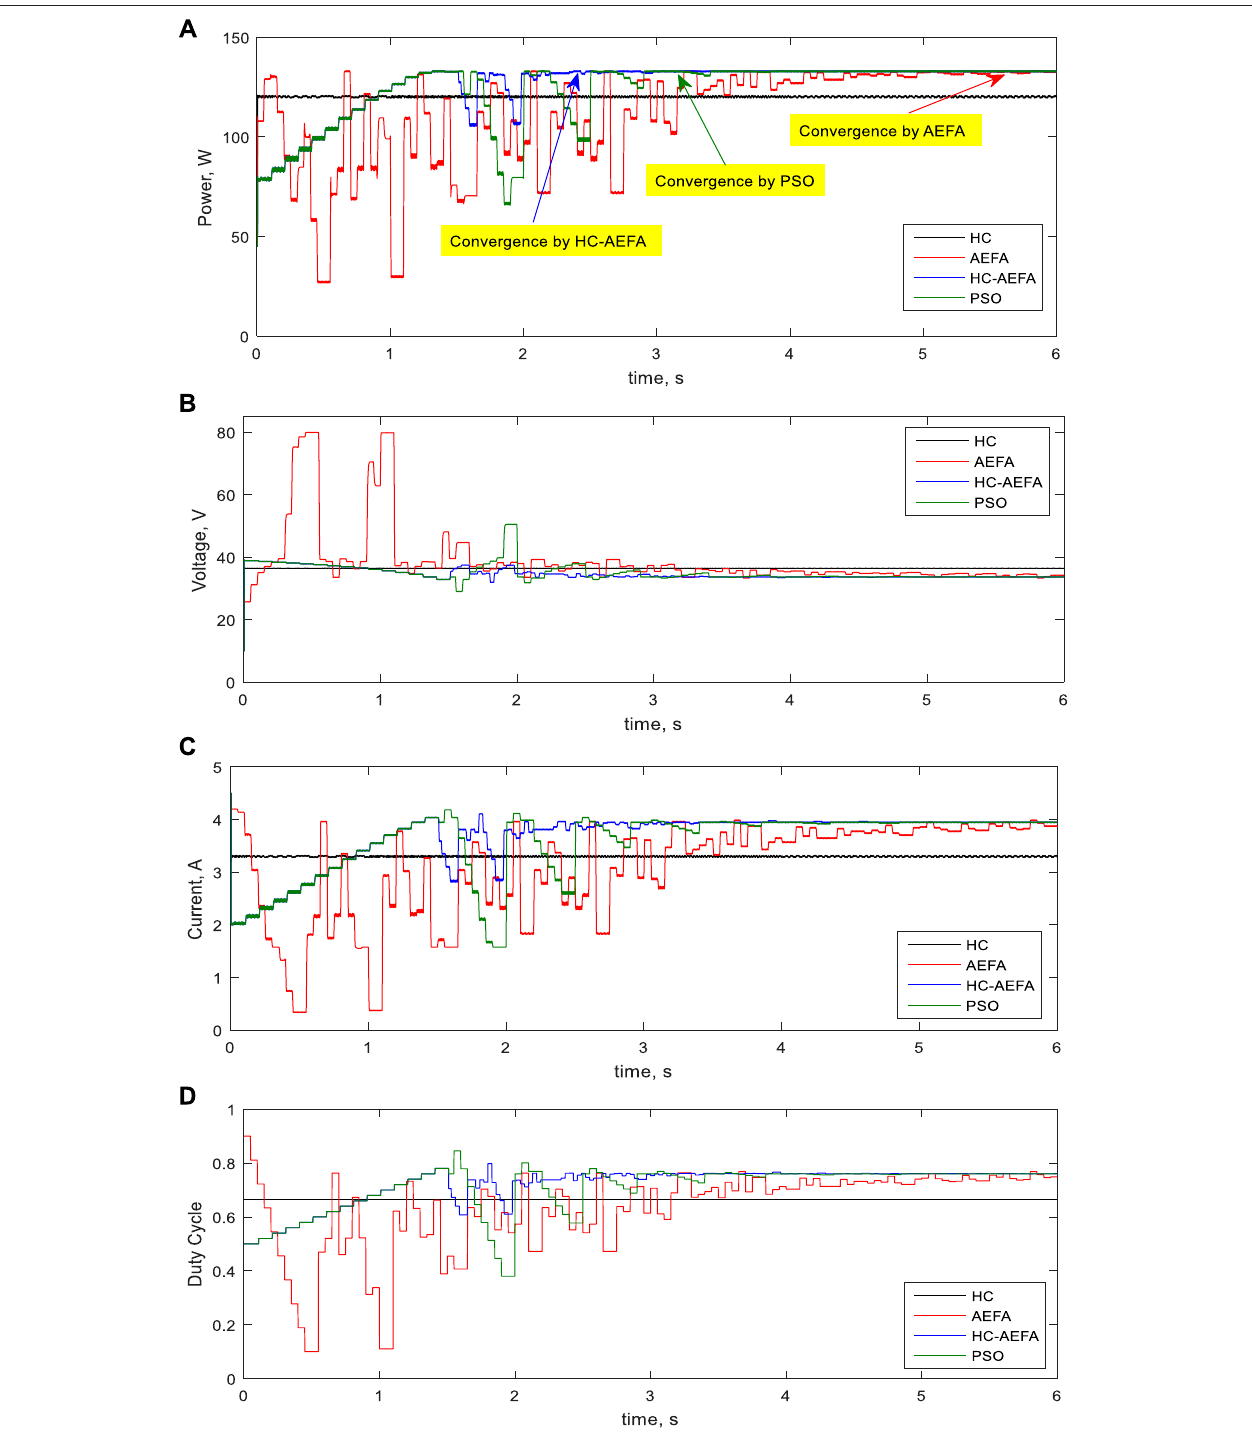
FIGURE 10 | Simulation waveforms at the third pattern obtained using the HC-AEFA, HC, AEFA, and PSO methods; (A) PV output power, (B) PV output voltage, (C) PV output current, and (D) converter duty-cycle curves.